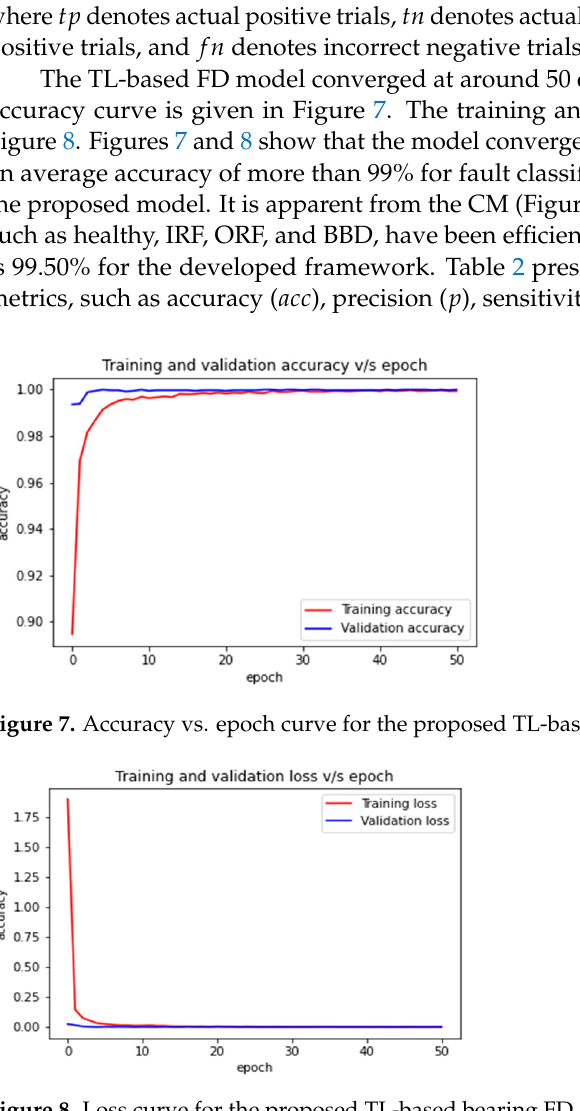
Figure 8. Loss curve for the proposed TL-based bearing FD approach.